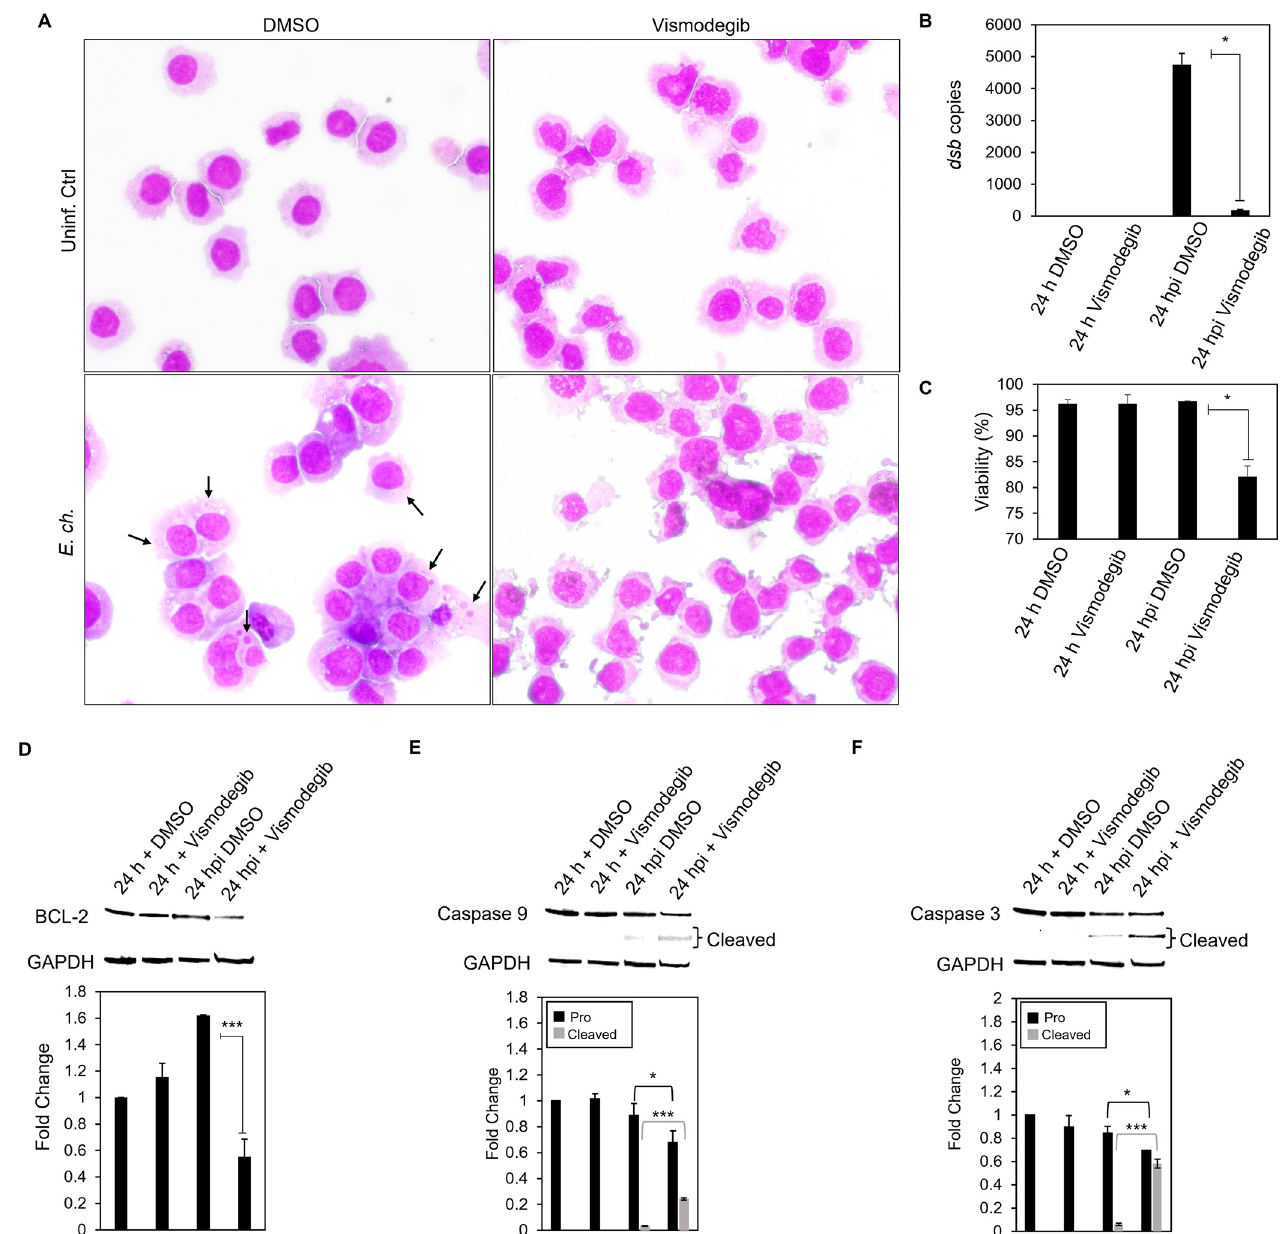
Fig 12. Apoptotic profile is induced in the presence of Hh inhibitor during E . chaffeensis infection. (A) Brightfield micrographs showing effects of DMSO or Hh inhibitor Vismodegib on uninfected and E . chaffeensis infected THP-1 (MOI 50) cells prepared using Diff-Quick staining. THP-1 cells were treated with Vismodegib or DMSO (200 nM) and infected with E . chaffeensis or uninfected for 24 h. Infected THP-1 cells treated with Vismodegib undergo cytoplasmic condensation (precursor to apoptosis), but other treatment groups do not (arrows point to morulae). (B) Bar graph showing fold-change in E . chaffeensis infection for each treatment group. Ehrlichial loads were determined using qPCR measurement of dsb copy and normalized with host cell GAPDH . E . chaffeensis infection significantly declines in the presence of Vismodegib. (C) Bar graphs showing cell viability for each treatment group. Cell viability was determined using the Cellometer Mini bright field imaging and pattern-recognition assay. Cell viability significantly declines in the presence of Vismodegib during E . chaffeensis infection. (D) Western blot analysis of BCL-2 levels for each group with GAPDH as a loading control. BCL-2 protein expression significantly declines during E . chaffeensis infection in the presence of Vismodegib. (E) Western blot analysis of pro and cleaved caspase 9 levels for each group with GAPDH as a loading control. Pro caspase 9 protein expression significantly declines while cleaved caspase 9 protein expression significantly increases during E . chaffeensis infection in the presence of Vismodegib. (F) Western blot analysis of pro and cleaved caspase 3 levels for each group with GAPDH as a loading control. pro caspase 3 protein expression significantly declines while cleaved caspase 3 protein expression significantly increases during E . chaffeensis infection in the presence of Vismodegib. (D-F) Bar graphs depict Western blot densitometry values normalized to GAPDH. (B-F) (A-F) Experiments were performed with at least three biological and technical replicates and significance was determined through t -test analysis. Data are represented as means ± SD ( � p < 0.05; �� p < 0.01; ��� p < 0.001).